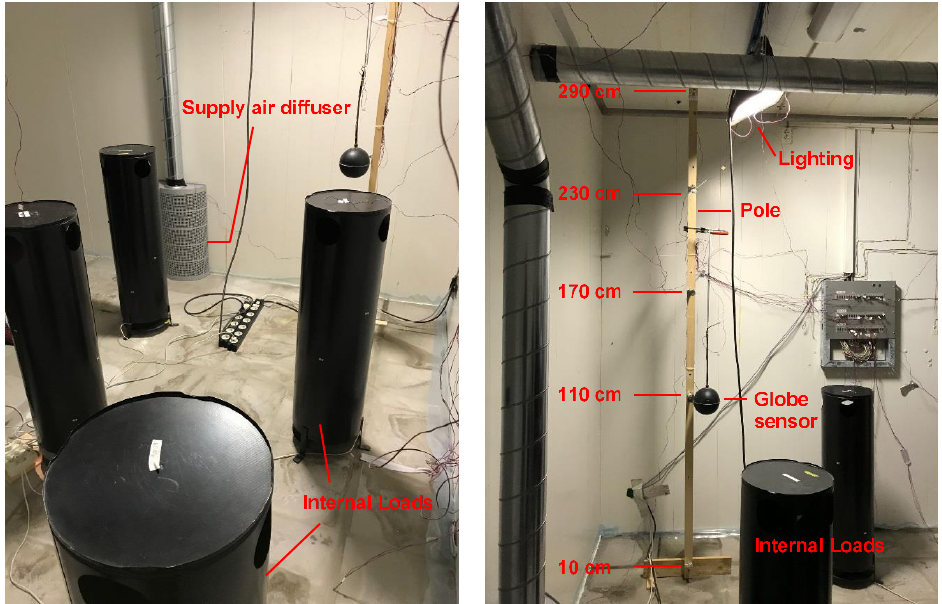
Figure 4. Floor plan of the test room with measurement points and internal heat sources (people: grey, lighting: yellow, equipment: green).